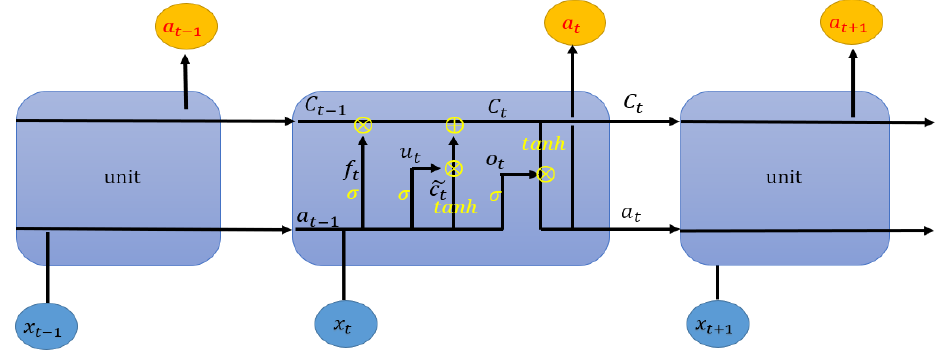
Figure 2. The structure of full convolution model.